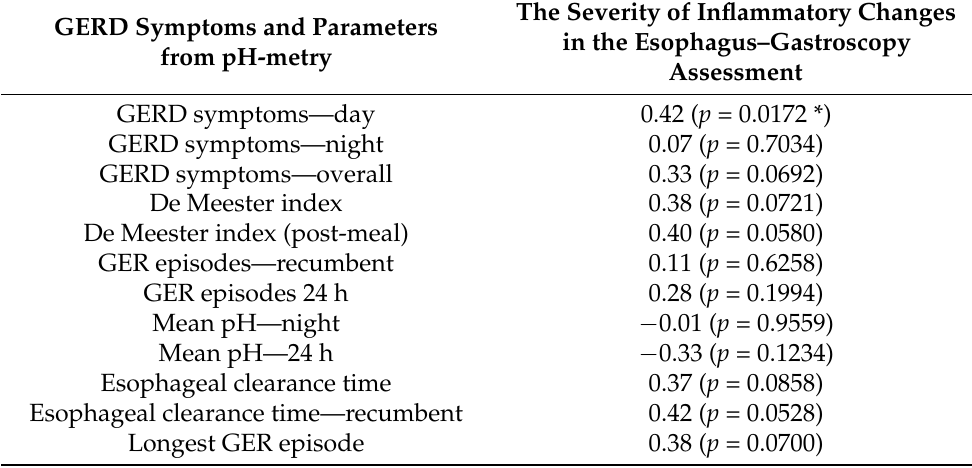
Table 4. Correlations of esophagitis severity with GERD symptoms and esophageal pH monitoring parameters (statistically significant correlations, where p < 0.05, are marked using